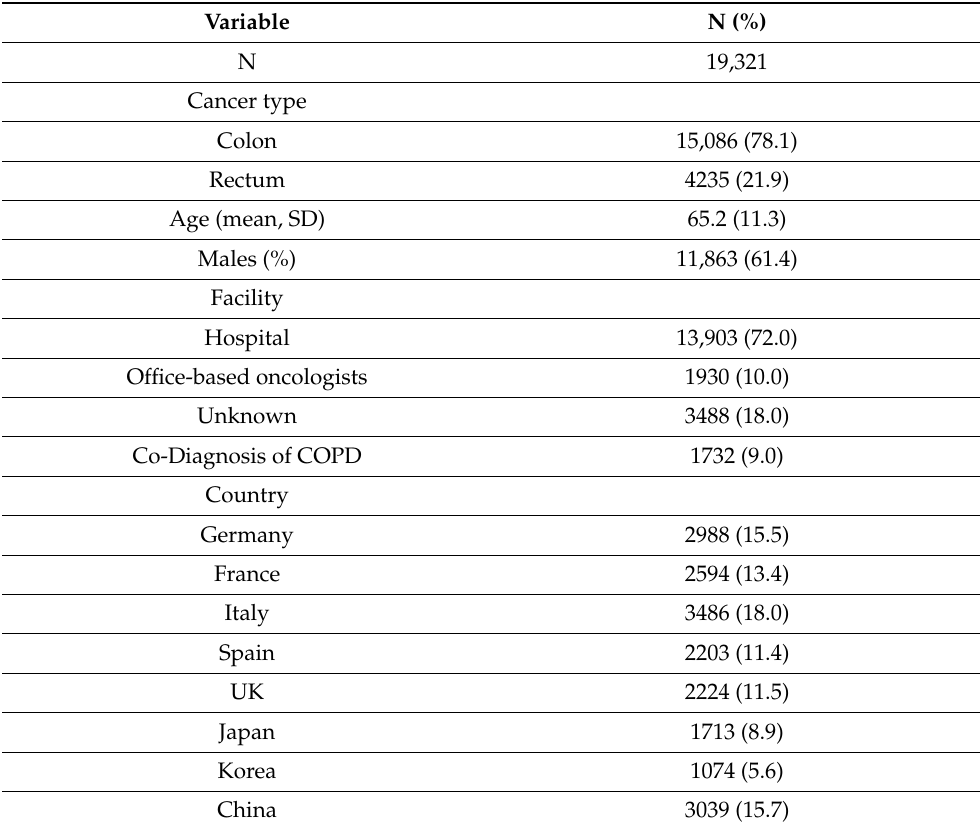
Table 1. Baseline characteristics of study patients.